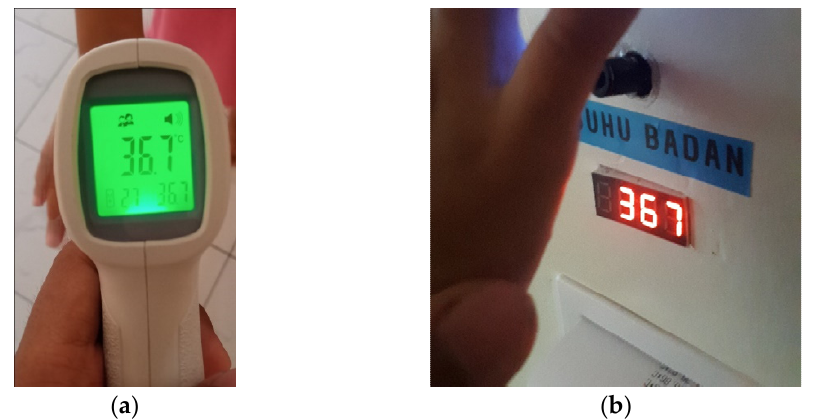
Figure 11. Body temperature measurement on: ( a ) Commercial Device; and ( b ) MLX90614-DCI Sensor. Table 2. Results of body temperature measurement using conventional tools and prototype of anthropometric